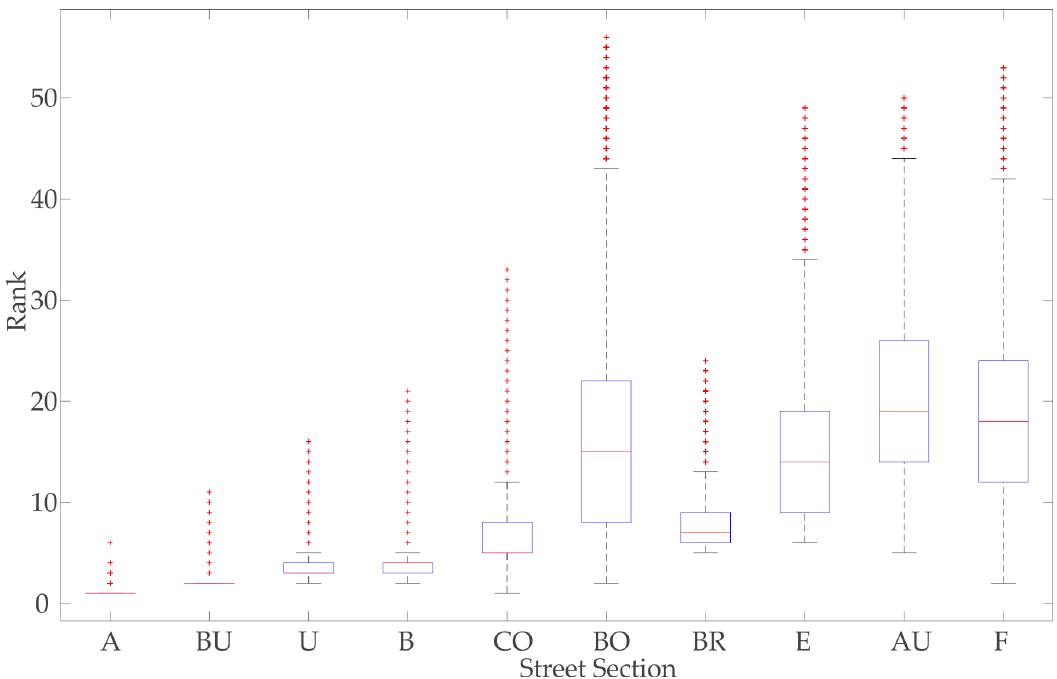
Figure 15. Sensitivity analysis for the total network for the AHP.